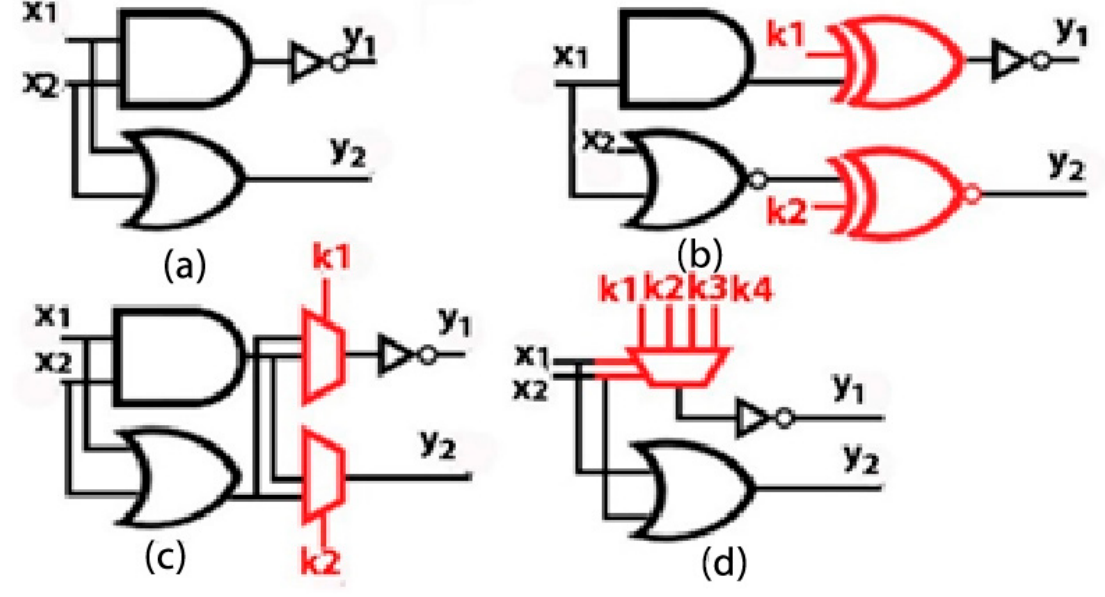
Figure 2. Combined logic locks [4]. The figure depicts a general overview of logic locking techniques, with a series of key gates and locked key inputs used to lock the circuit. The key input connects to a memory on the chip to be IC locked. Hence, the only way to maintain proper performance is to configure the correct key in the chip memory. NOT ( a , b ), XOR ( c ), and Multiplexer ( d ) gates are examples of these gates